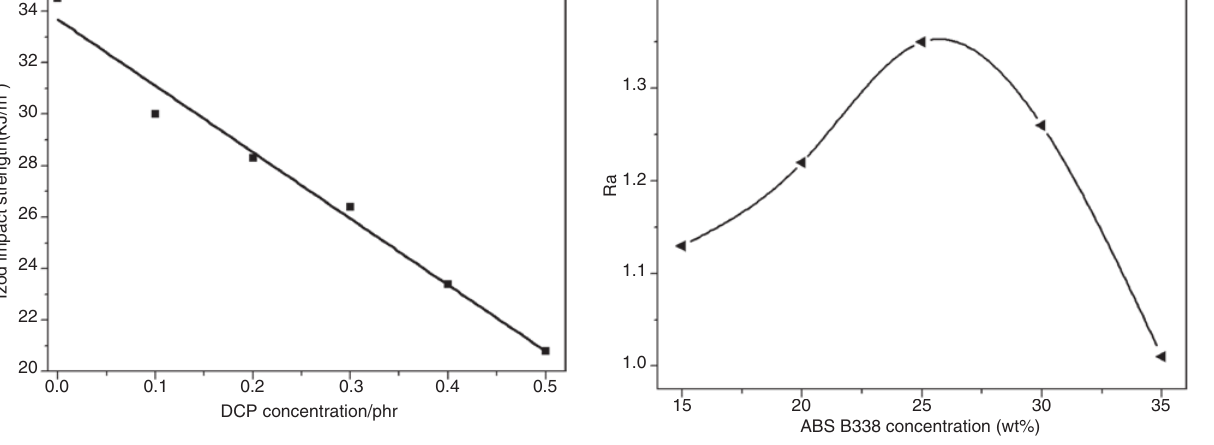
Figure 9 Effect of ABS B338 concentration on the grafting polymerization.